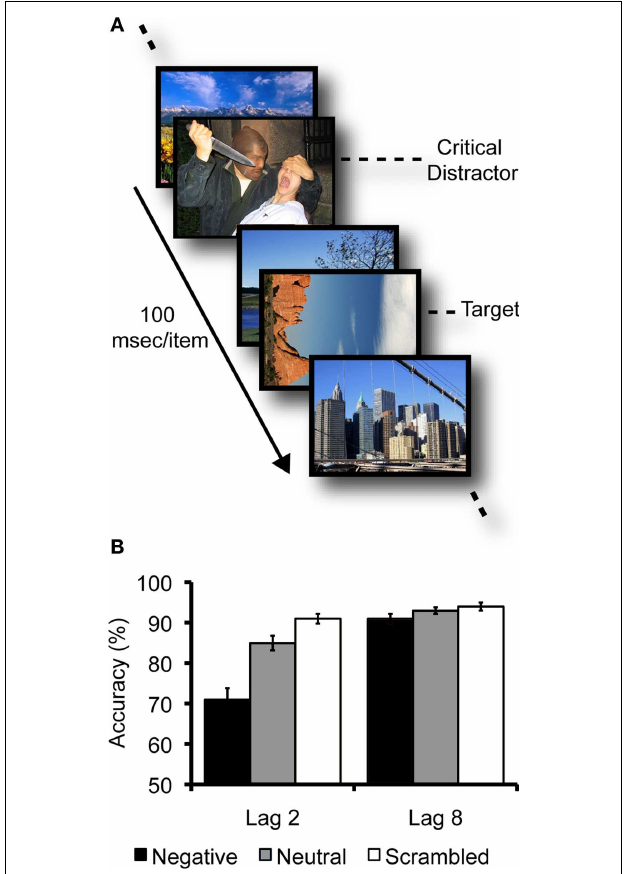
FIGURE 1 | (A) Example of part of a typical emotion-induced blindness trial, where items are presented serially at a rate of 100ms/item. Here, the target is a landscape picture rotated 90˚ clockwise.The critical distractor is an emotionally negative picture that appears two items before the target (Lag 2). (B) A typical pattern of data (means and standard errors) from an emotion-induced blindness experiment (from Most et al., 2005, Experiment 1). At Lag 2, accuracy in reporting the target’s orientation was worse following emotional distractors than following neutral or scrambled distractors. However, by Lag 8, performance in all distractor conditions had recovered to above 90%